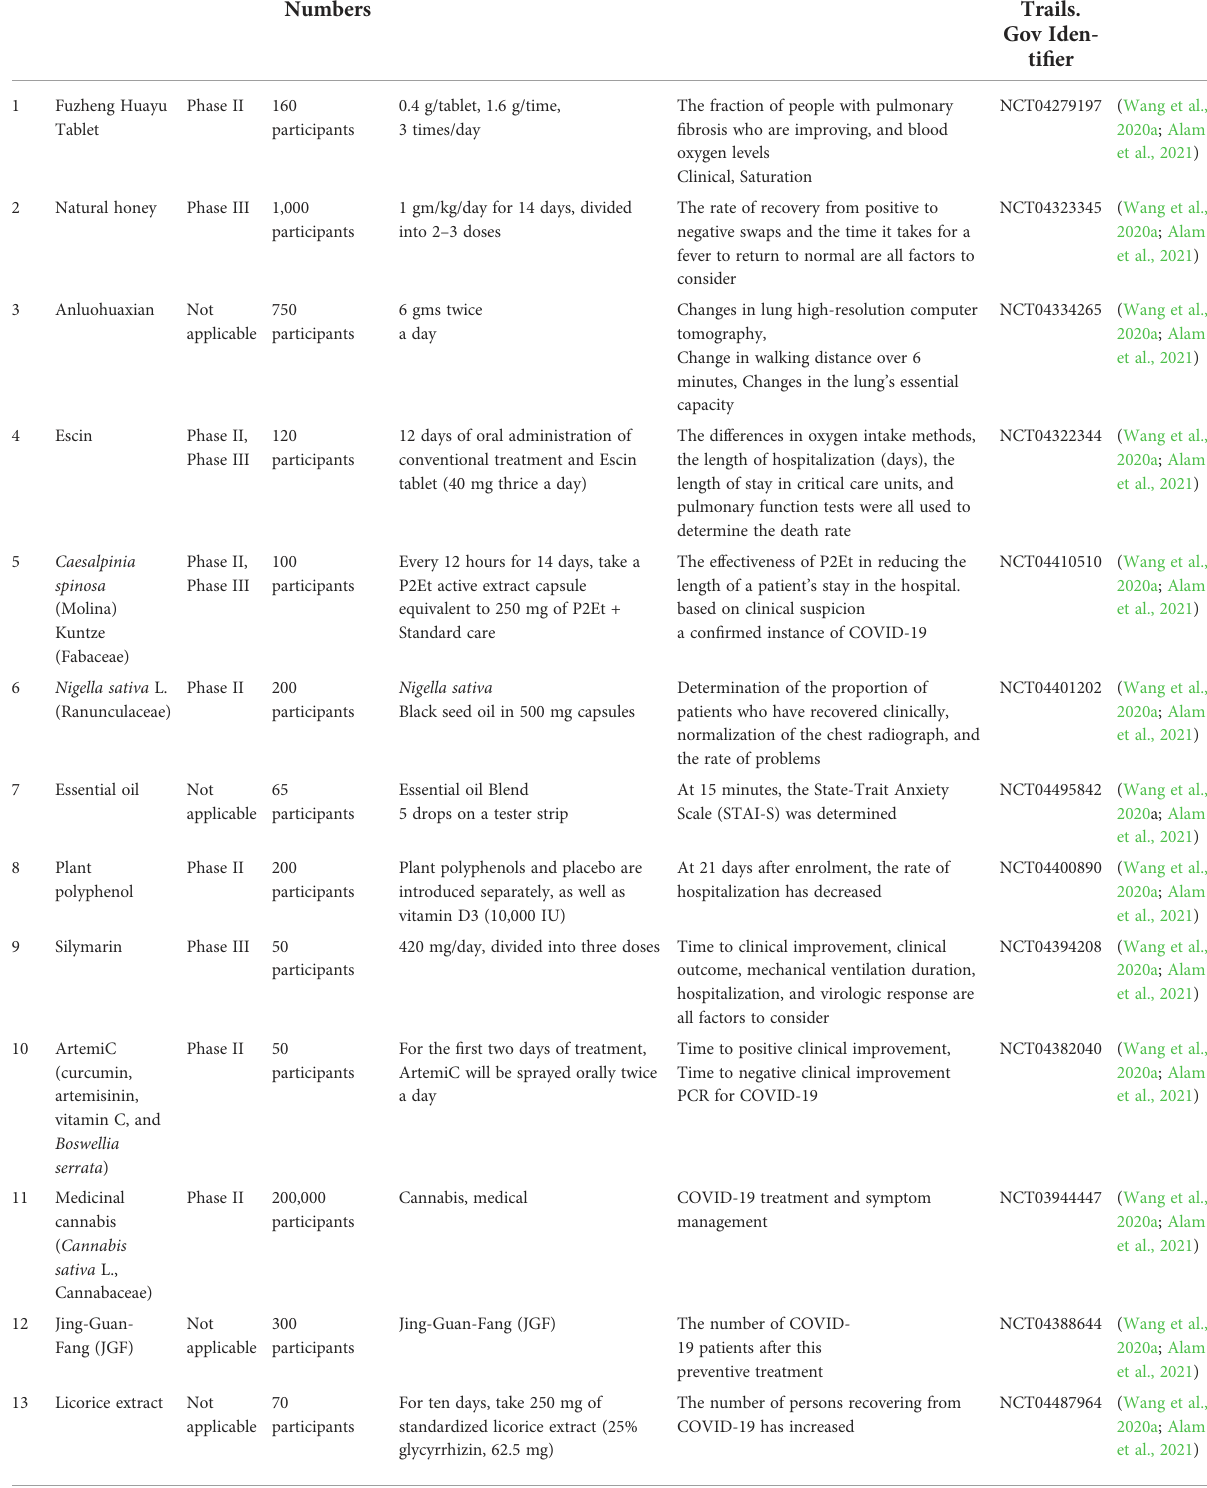
TABLE 2 Ongoing clinical trials of several plants, functional foods, and plant-based products against SARS-CoV-2